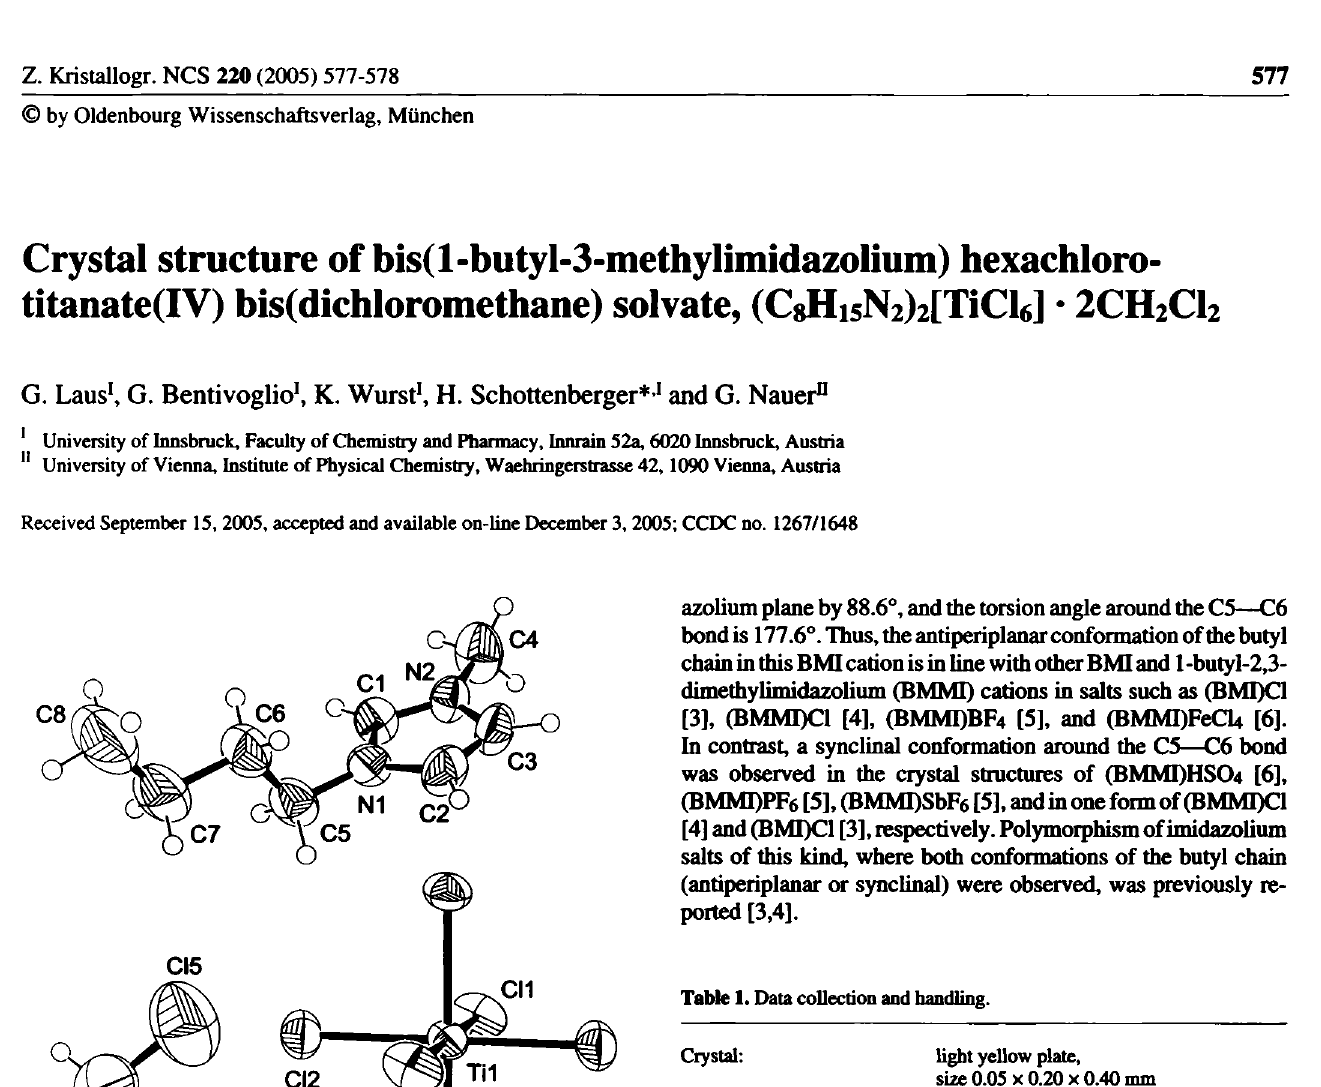
Table 1. Data collection and handling.